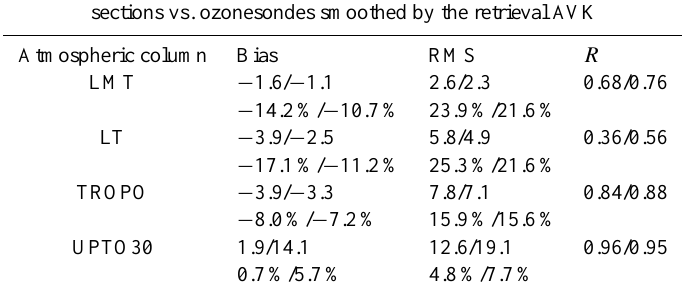
Table 6. Evaluation of potential effects of spectroscopic incoherencies between the UV and TIR data sets on the multispectral ozone retrieval. The same comparison (105 ozonesondes smoothed by the retrieval AVKs) as in Table 2 is performed, but for 2 test cases: (left) using TIR spectroscopic parameters from HITRAN 2000 or (right) decreasing UV cross sections by − 5 % with respect to BRION1993.